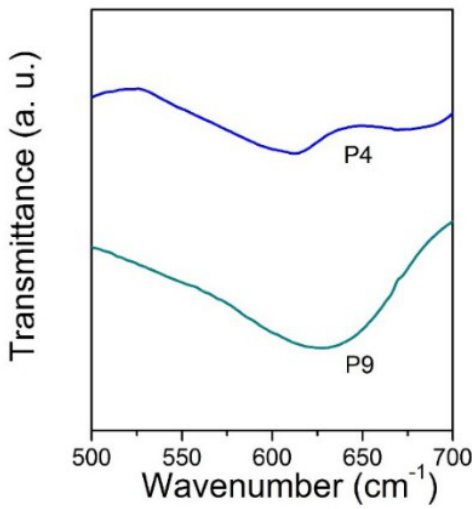
Figure 6. FT-IR spectra of discharged P4 and P9 thin films.